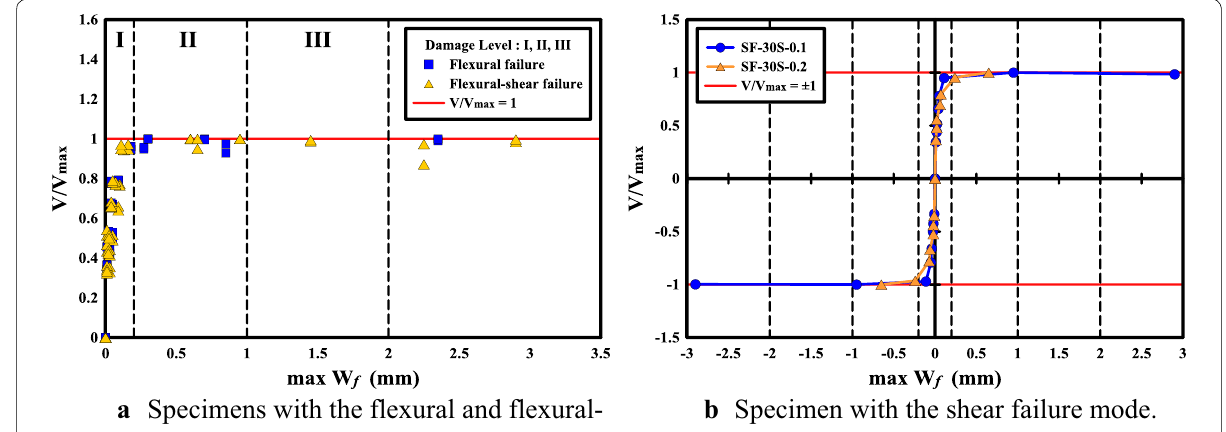
The value in the parentheses represent experimental reduction factors.